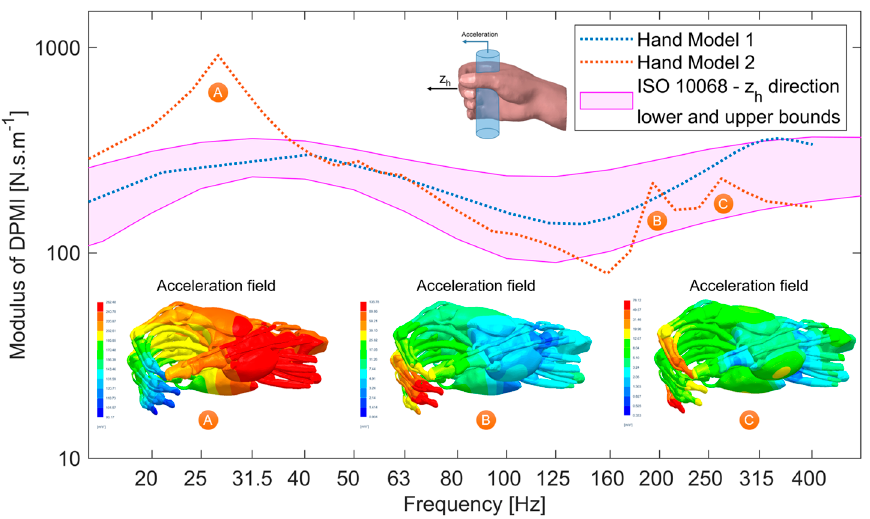
Figure 9. The module of the Driving Point Mechanical Impedance (DPMI) in direction z h . Comparison of Hand Models 1 and 2 with standard ISO 10068 [83]. The acceleration fields in the hands shown at the bottom of the figure correspond to the frequencies A, B, and C shown in the top half of the figure.